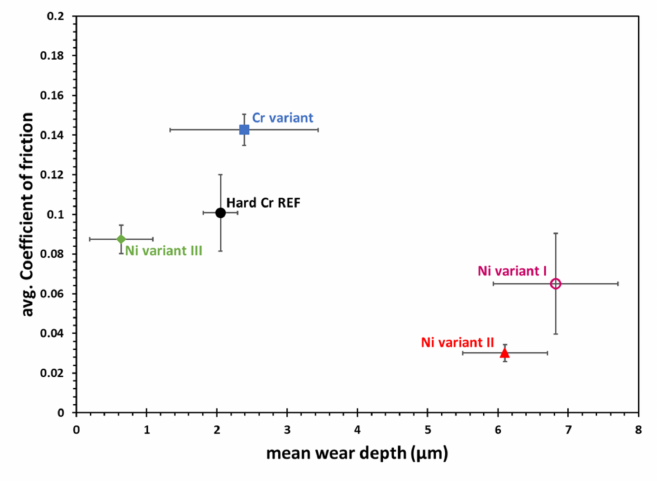
Figure 11. Relative ranking of hard Cr reference and candidate coatings in terms of mean wear and